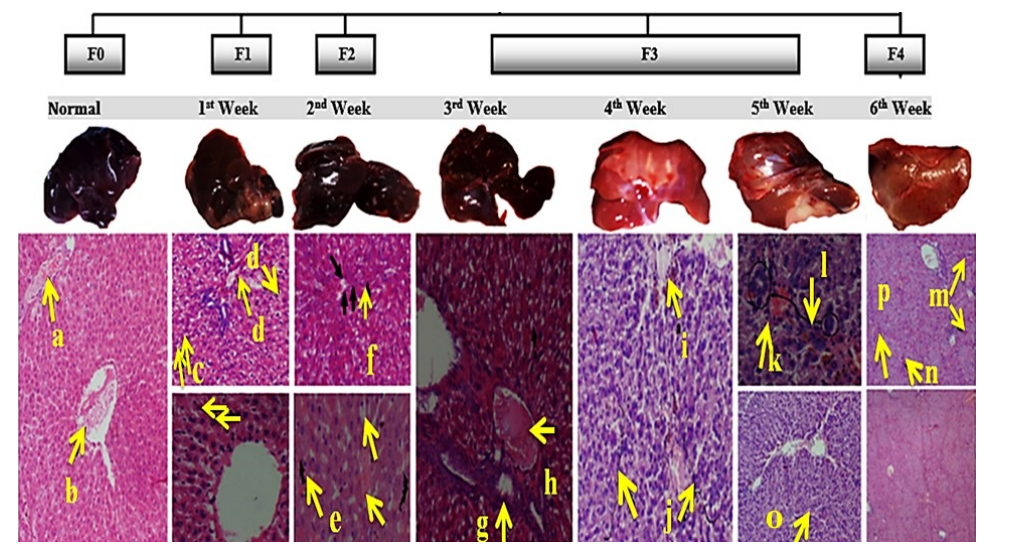
Figure 4. Meta-analysis of histological data in viral hepatitis (METAVIR) staging/classification for fibrosis and per week histopathology of the liver during cirrhosis induction. Normal ( a , b ), indications of mild fatty liver in first week ( c , d ), more fatty appearance in second week ( e , f ), severe fatty deposition in third week ( g , h ), Cholestasis in fourth week ( i , j ), and, complete cirrhosis achieved in fifth and sixth week ( k , l ).